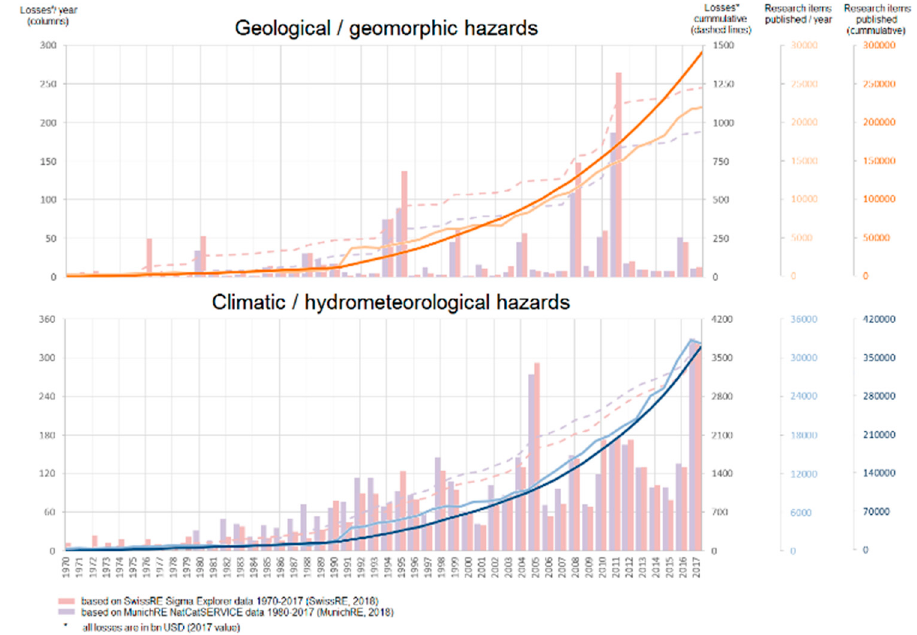
Figure 7. Research on geological/geomorphic and climatic/hydro-meteorological natural hazards and losses caused (losses estimations based on [1,5]).